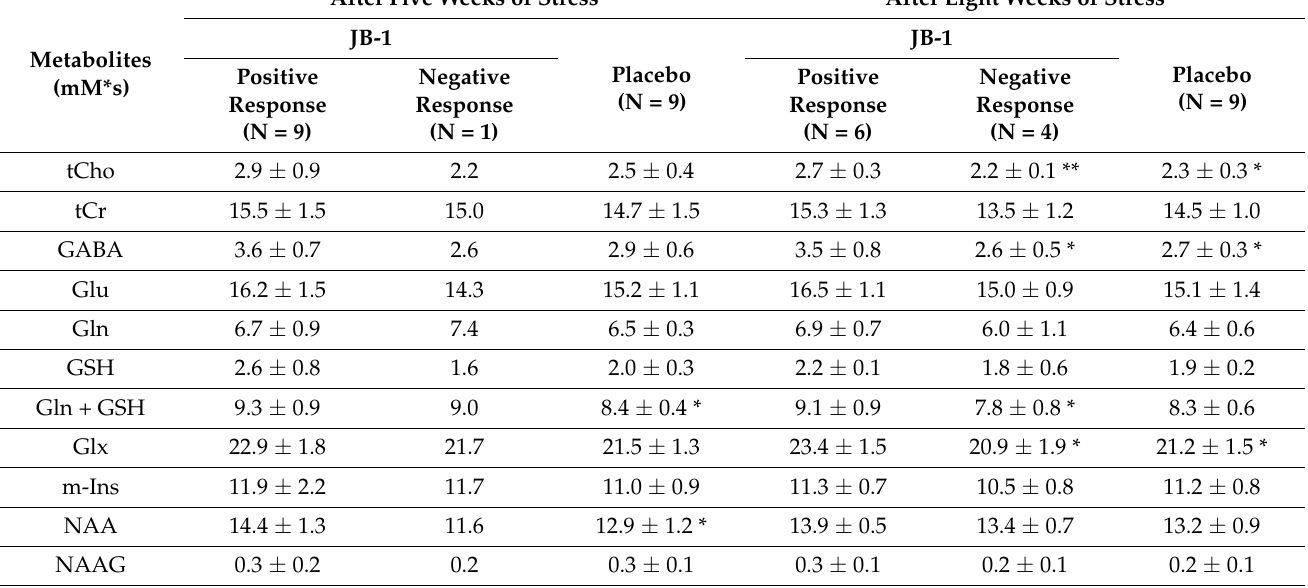
Table 2. Neurometabolites’ concentrations normalized to R 1 in JB-1 treatment and placebo groups after five and eight weeks stress protocol, with additional division of the JB-1 group according to behavioral response: “Positive response”—behavioral score > 0, “Negative response”—behavioral score = 0. Data presented as means ±